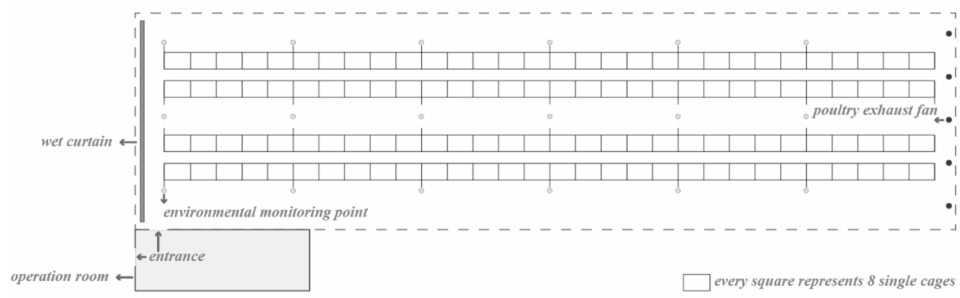
Figure 1. Schematic diagram of environmental indicators test points. The hollow dots represent test